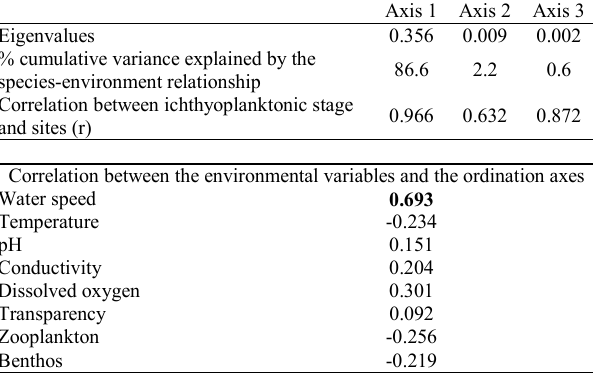
Table 4. Results of the Canonical Correspondence Analysis linking the abundance of the different ichthyoplanktonic stages in the sampling sites of the Ligeiro River (upper Uruguay River, Brazil) between September 2006 and March 2007; the Monte Carlo test was used for the significance of the first ordination axis (P < 0.05; n = 999 permutations). Bold values were statistically significant. Note: Total inertia =